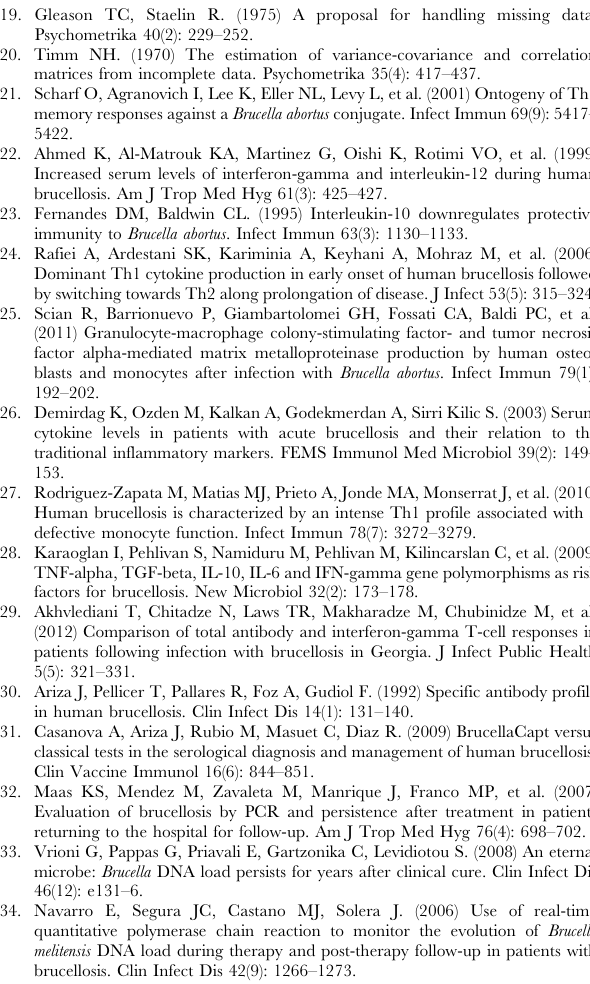
Figure S5 Data separation in the gene expression and cytokine secretion data sets. Scaled, log 10 -transformed response variables were taken from the full gene expression data set (left) and the partial, imputed cytokine secretion data set (right), where no variable was missing more than four values and no patient category was missing more than one value (see Methods). Variables for which relapse patients exhibited a mean value less than that of control subjects were inverted (multiplied by 2 1). The density of the resulting variables was estimated using the ‘density’ function in R, then overlayed by patient category: control (green), acute (blue) and relapse (red).